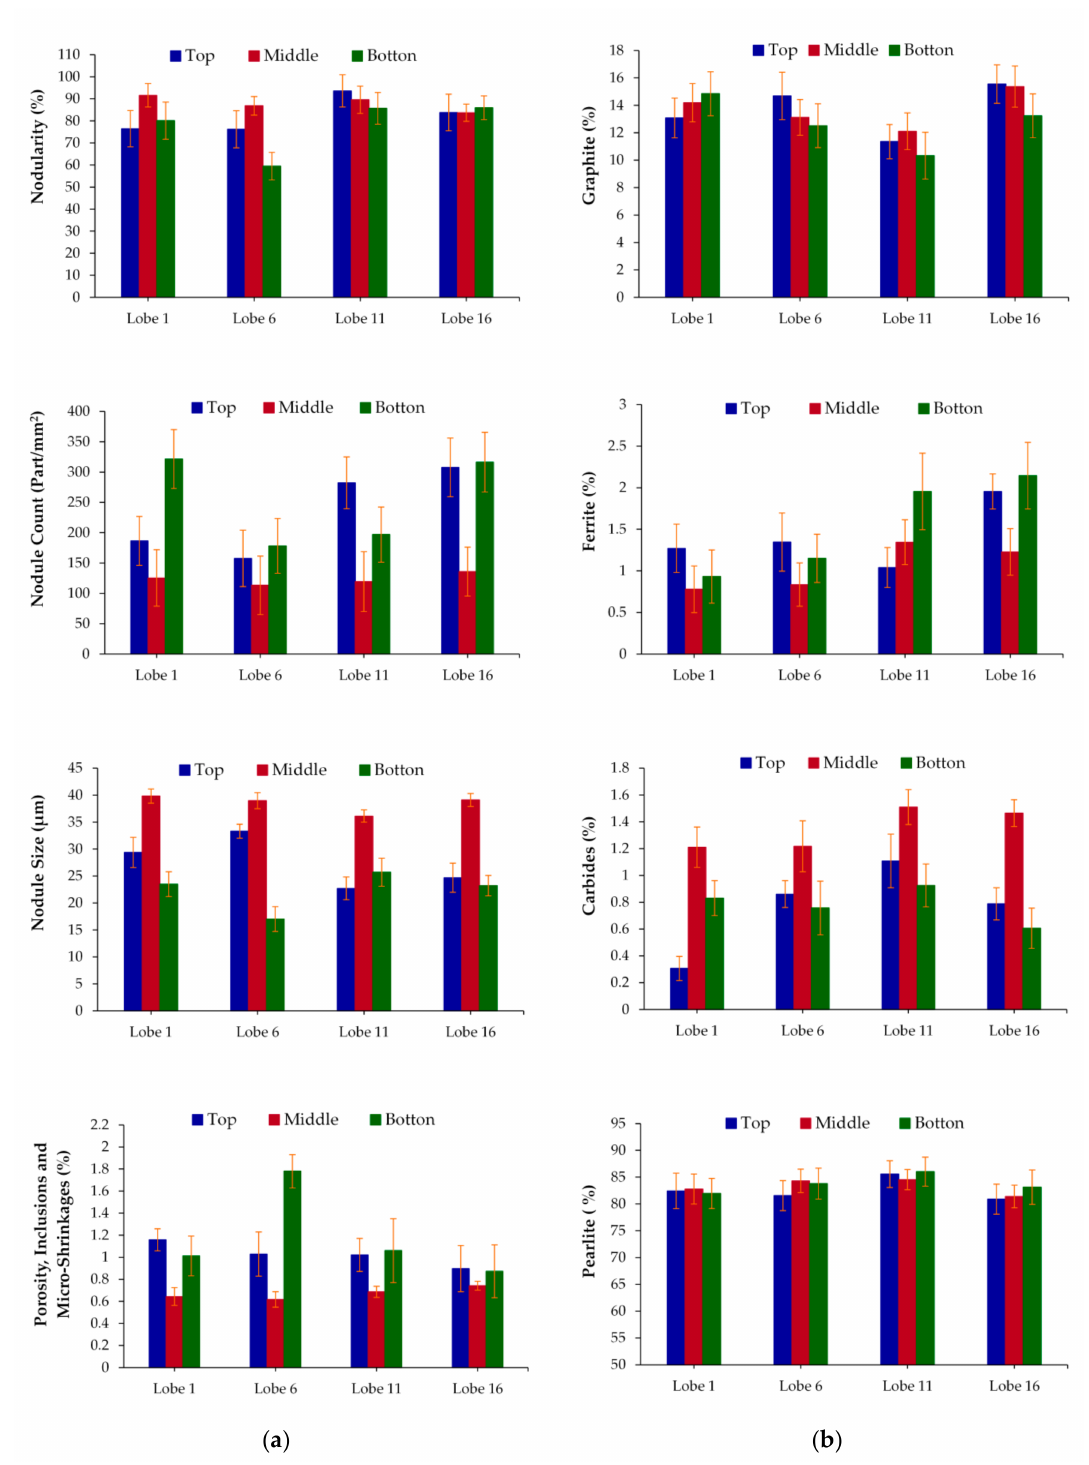
Figure 4. Microstructural characterization of the ductile iron alloyed with 0.3 wt % V for different lobes and regions analyzed to ( a ) graphite features ( b )